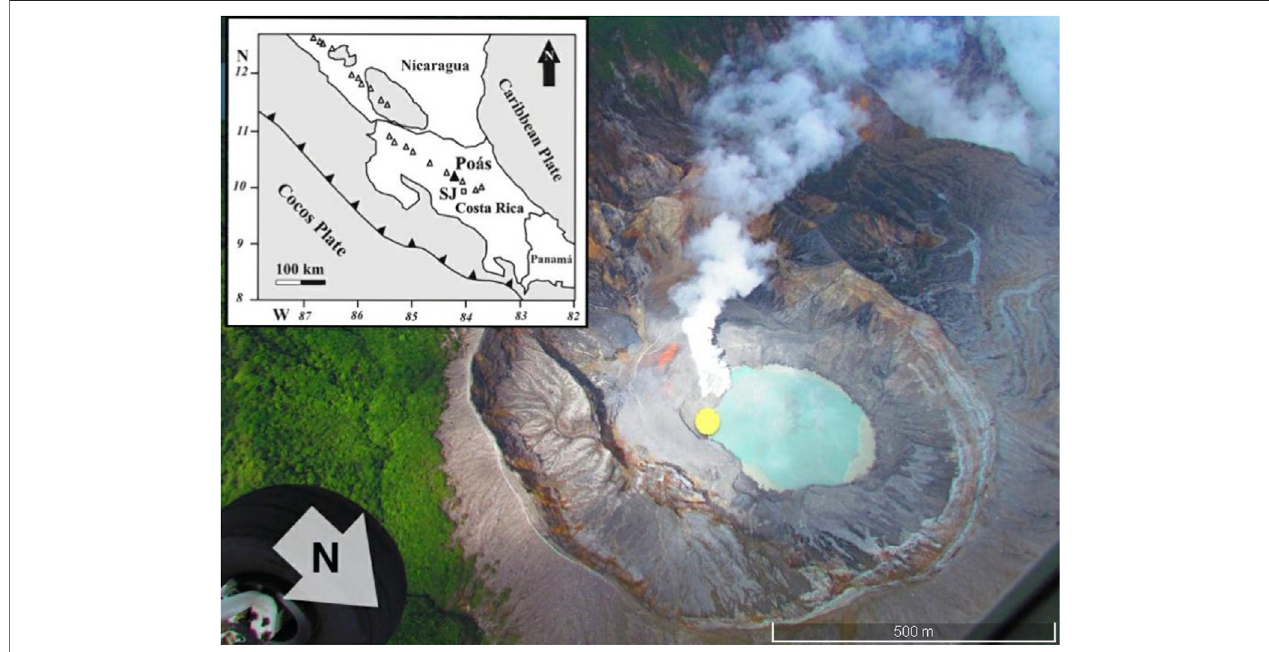
FIGURE 1 | Map of the Cordillera Volcánica Central and location of Poás volcano, Costa Rica (black triangle) (Rouwet et al., 2017). Aerial photograph of Laguna Caliente (Poás volcano) and location of the sampling point “ LD ” at the dome (yellow dot). The photo was taken by Raúl Mora-Amador on 17/04/2012.